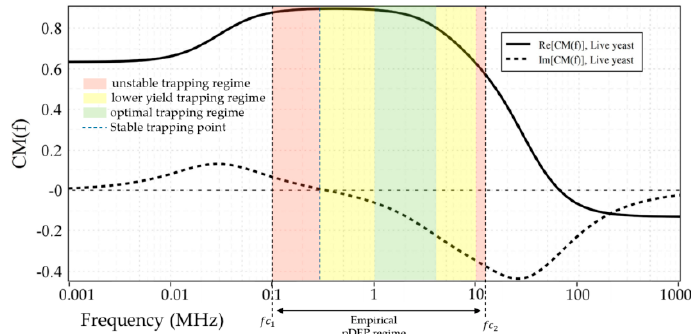
Figure 5. Empirically proven pDEP regime and crossover frequencies ( fc ) vs. numerical predictions for live yeasts suspended in DIW. Colored frequency bands represent trapping behavior based on microscopical observations.